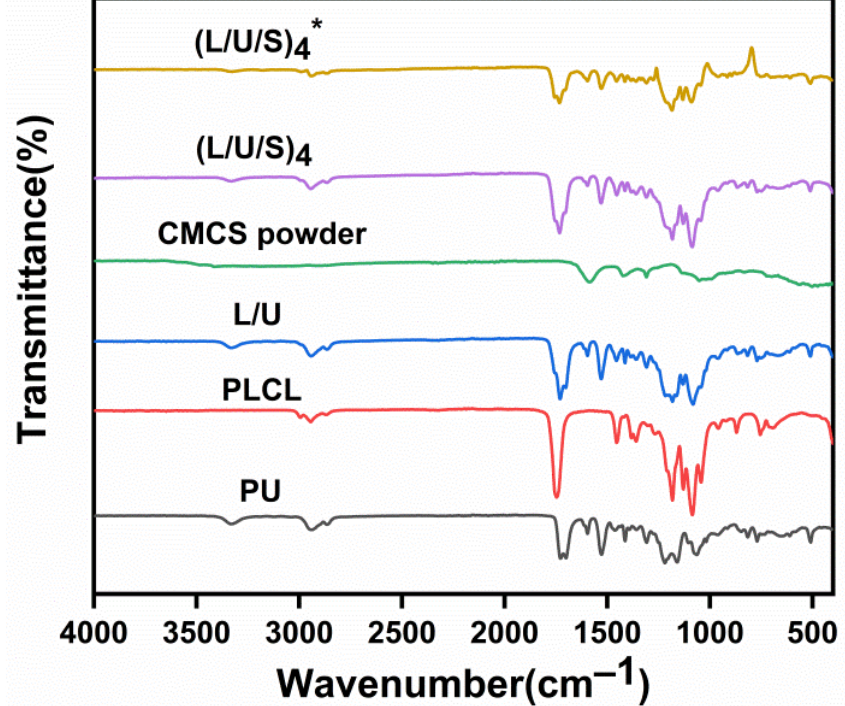
Figure 4. FTIR spectra of PU/PLCL/CMCS electrospun fibers. (L/U/S) 4* referred to the sample after (L/U/S) 4 was cross-linked.